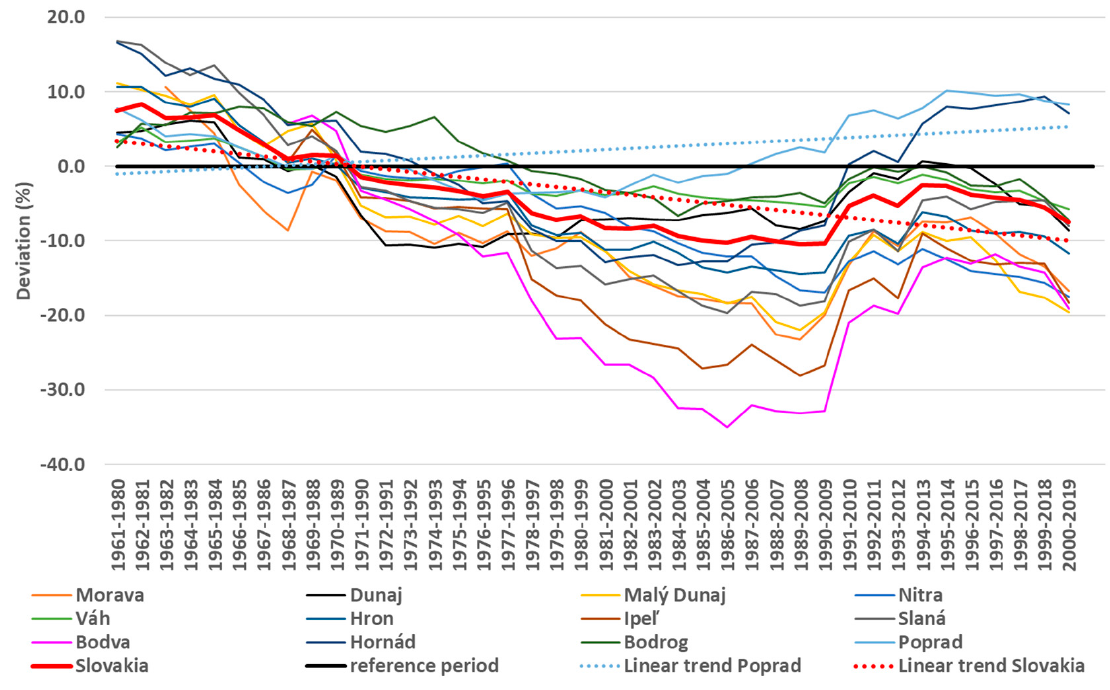
Figure 3. The course of 20-year moving values of the average deviations (%), reference period 1961– 2000.